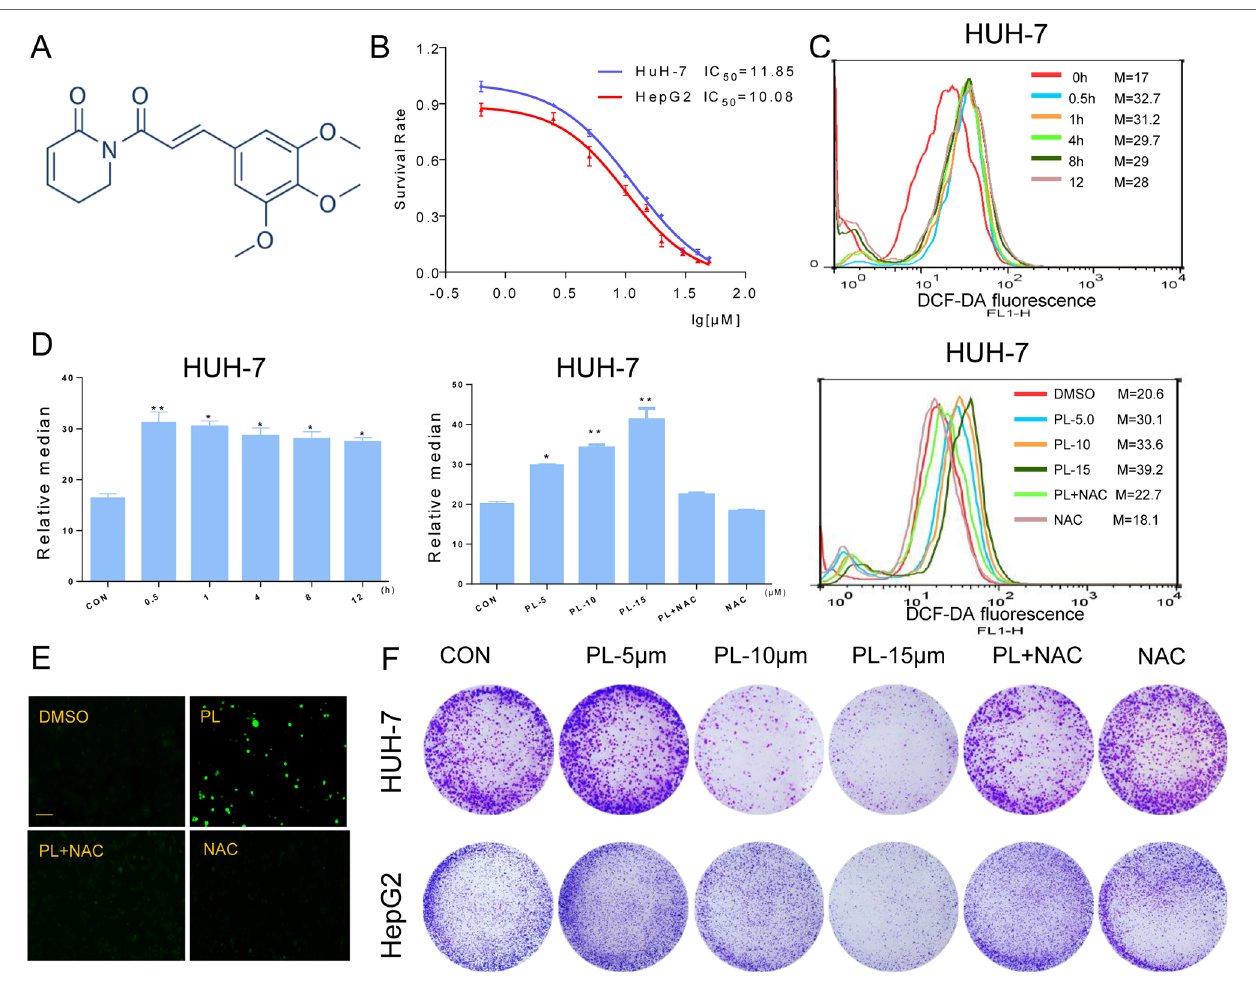
FIGURE 1 | PL inhibits cell growth and induces ROS accumulation in HCC cells. (A) Chemical structure of PL. (B) The effect of PL on the proliferation of HCC cells. Cells were incubated with increasing doses of PL for 24 h, respectively. Cell viability was determined by MTT assay. (C) Intracellular ROS generation in HUH-7 cells was determined in a time- and dose-dependent manner using the redox-sensitive dye DCFH-DA (10 μM). HUH-7 cells were treated with PL (15 μM) for the indicated times. HUH-7 cells were preincubated with or without 5 mM NAC for 2 h before exposure to PL at the indicated concentrations for 30 min. Intracellular ROS generation was measured by flow cytometry. (D) Quantification of 2’-,7’dichlorofluorescein (DCF) fluorescence data from (C) . (E) Intracellular ROS generation induced by PL was measured by fluorescence microscopy. Magnification, 200×. Bar, 100 µm. HUH-7 cells were preincubated with or without 5 mM NAC for 2 h before exposure to PL (15 μM) for 30 min. Then, intracellular ROS generation was measured by fluorescence microscopy. (F) Effect of PL treatment on colony formation. Cells were preincubated with or without 5 μM NAC for 1 h before exposure to PL at the indicated concentration for 5 h and then stained with crystal violet on day 8. Data represent similar results from three independent experiments. Error bars represent the S.E.M. of triplicate experiments (*p < 0.05, **p <